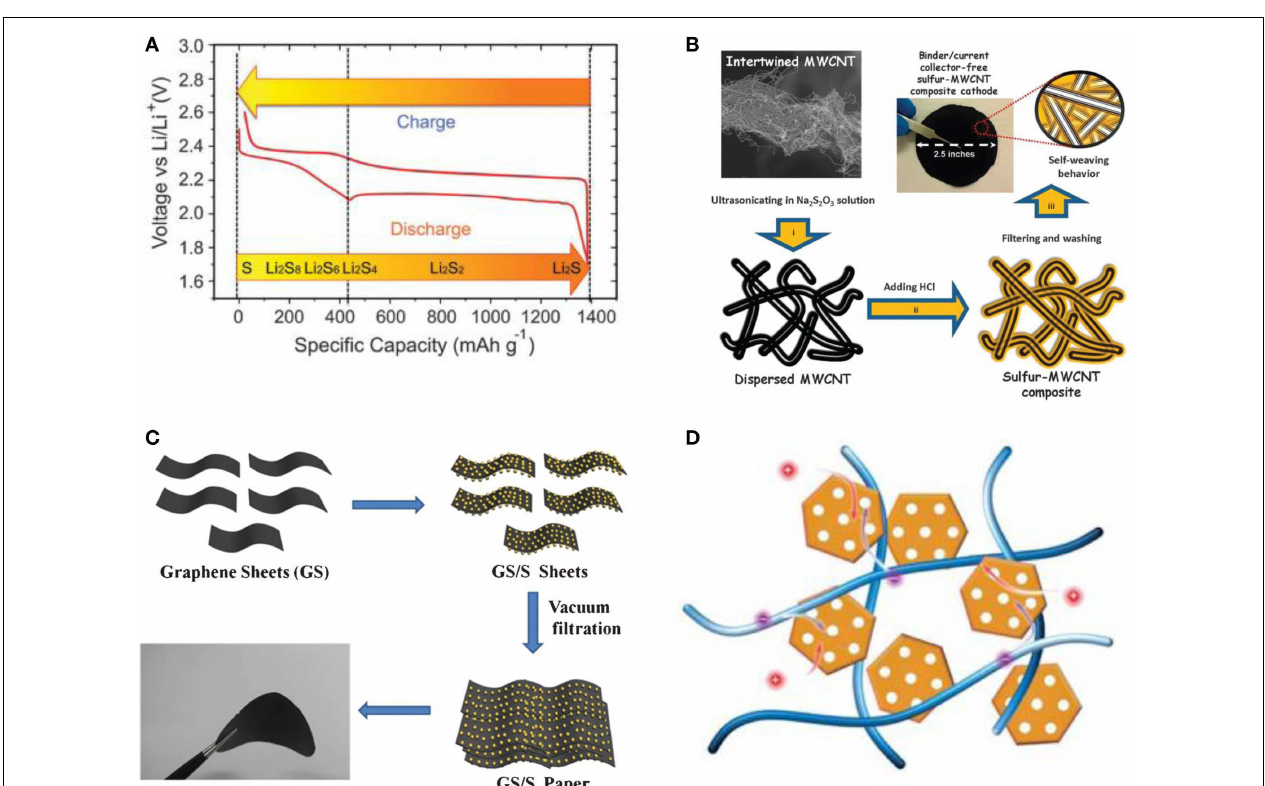
washing, and then drying. Reprinted with permission from Su et al. (2012). Copyright (2012) Royal Society of Chemistry. (C) Schematic illustration and photograph of the flexible self-supporting GS/S paper. Reprinted with permission from Jin et al. (2013a). Copyright (2012) Royal Society of Chemistry. (D) Schematics of sulfur cathode with CNT/carbon nanocage as scaffold. Reprinted with permission from Huang et al. (2014). Copyright (2014) Royal Society of